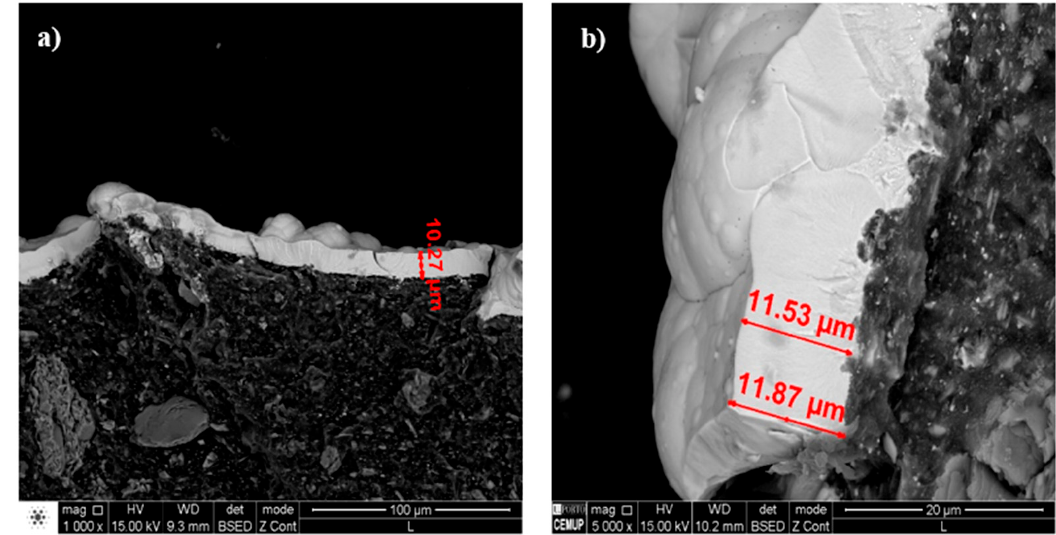
Figure 8. SEM micrographs of a cross-section of a Ni-P plated PHNBR sample for 120 min, from ( a ) the middle of the sample and ( b ) the bottom corner of the sample.